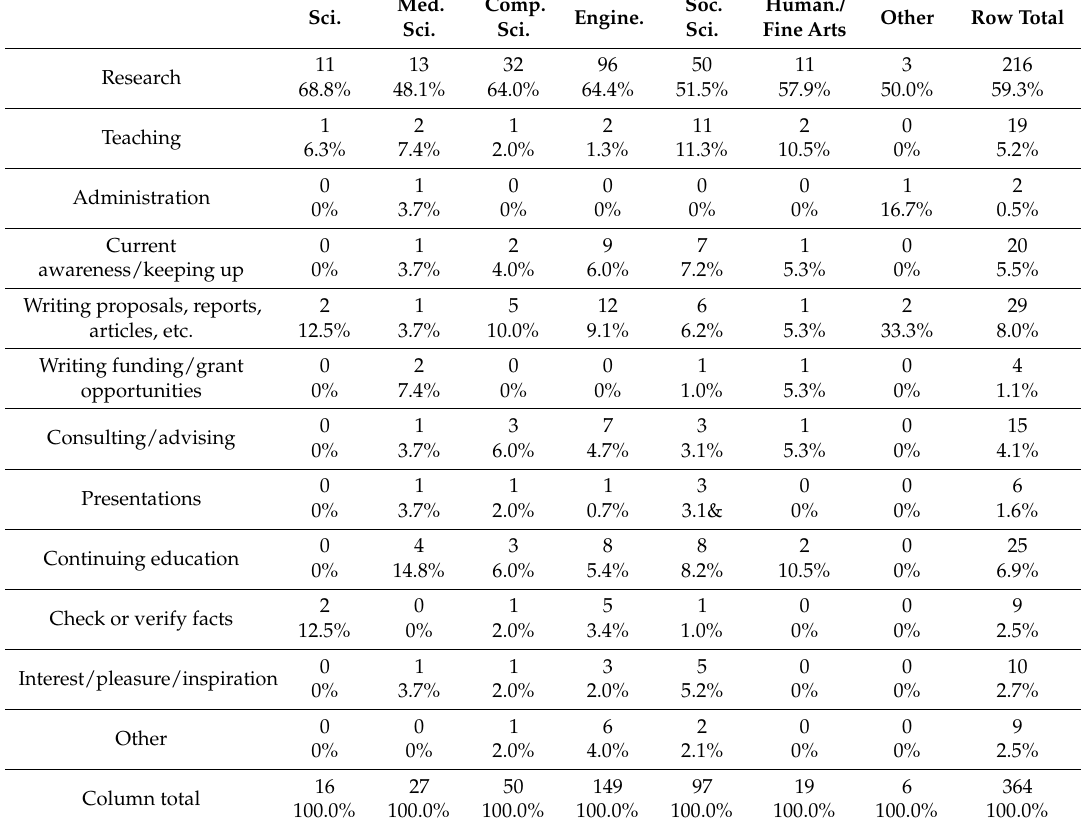
Table 24. Purpose of reading by subject disciplines